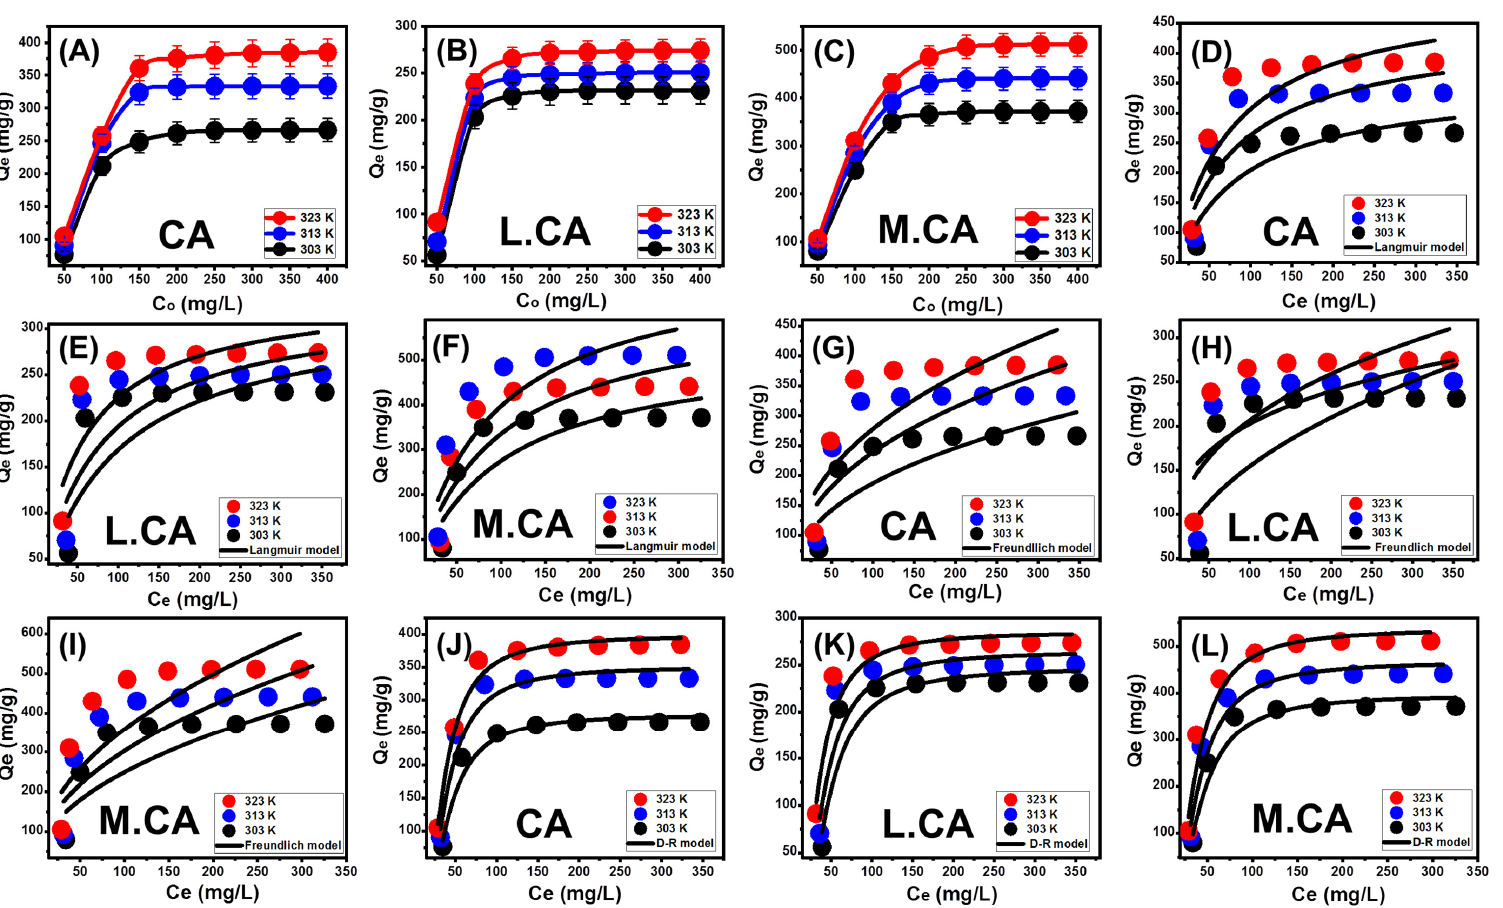
Figure 4. The impact of Zn (II) concentration on its retention by the three calcite phases ( A – C ), fitting of the Zn (II) retention results with Langmuir model ( D – F ), fitting of the Zn (II) retention results with Freundlich model ( G – I ), and fitting of the Zn (II) retention results with D-R model ( J – L ).